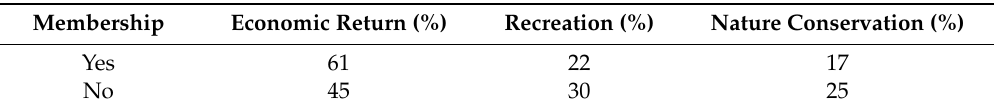
Table 6. Percentage of forest owners’ association members’ and non-members’ ranking economic return, recreation or nature conservation as the most important management objective ( n = 431).